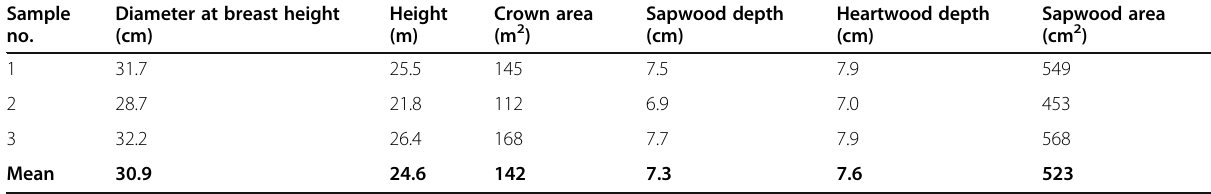
Table 1 Biometric characteristics of sampled trees Sample